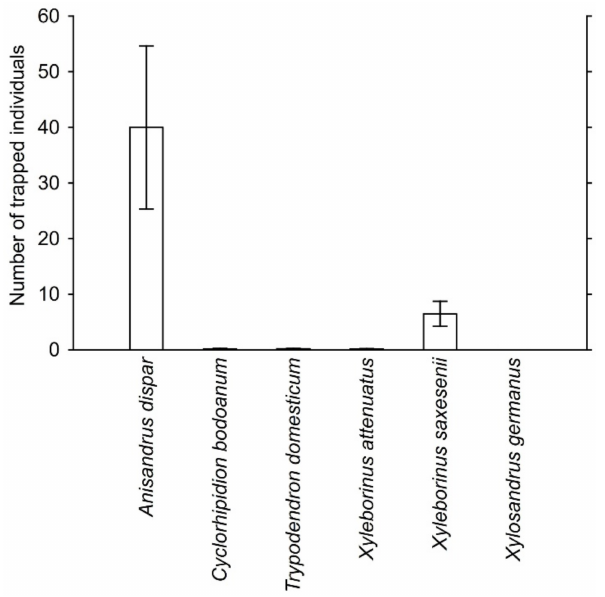
Figure 3. Number (mean ± SE) of individuals of ambrosia beetle species captured per sample. Each sample represented the beetles captured in one trap during 2-week